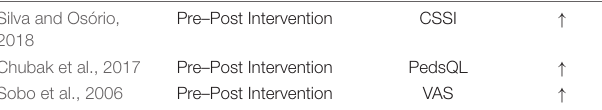
TABLE 3B | Effect of AAI on behavioral response to stress (uncontrolled studies).